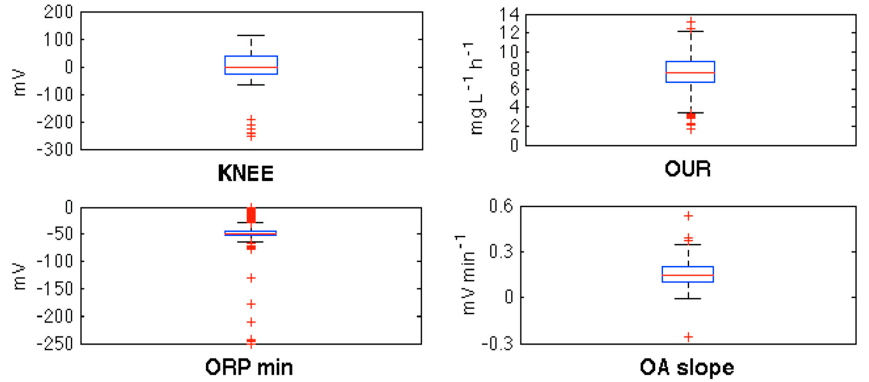
Figure 2. Box-plot of the 4 parameters with outliers which were rejected. The outliers are shown as red crosses.